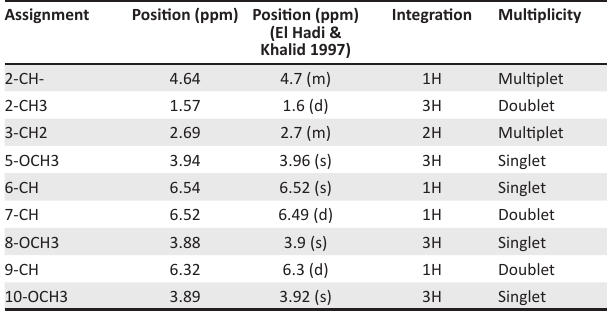
) of the subfraction (4/7/5) and 3